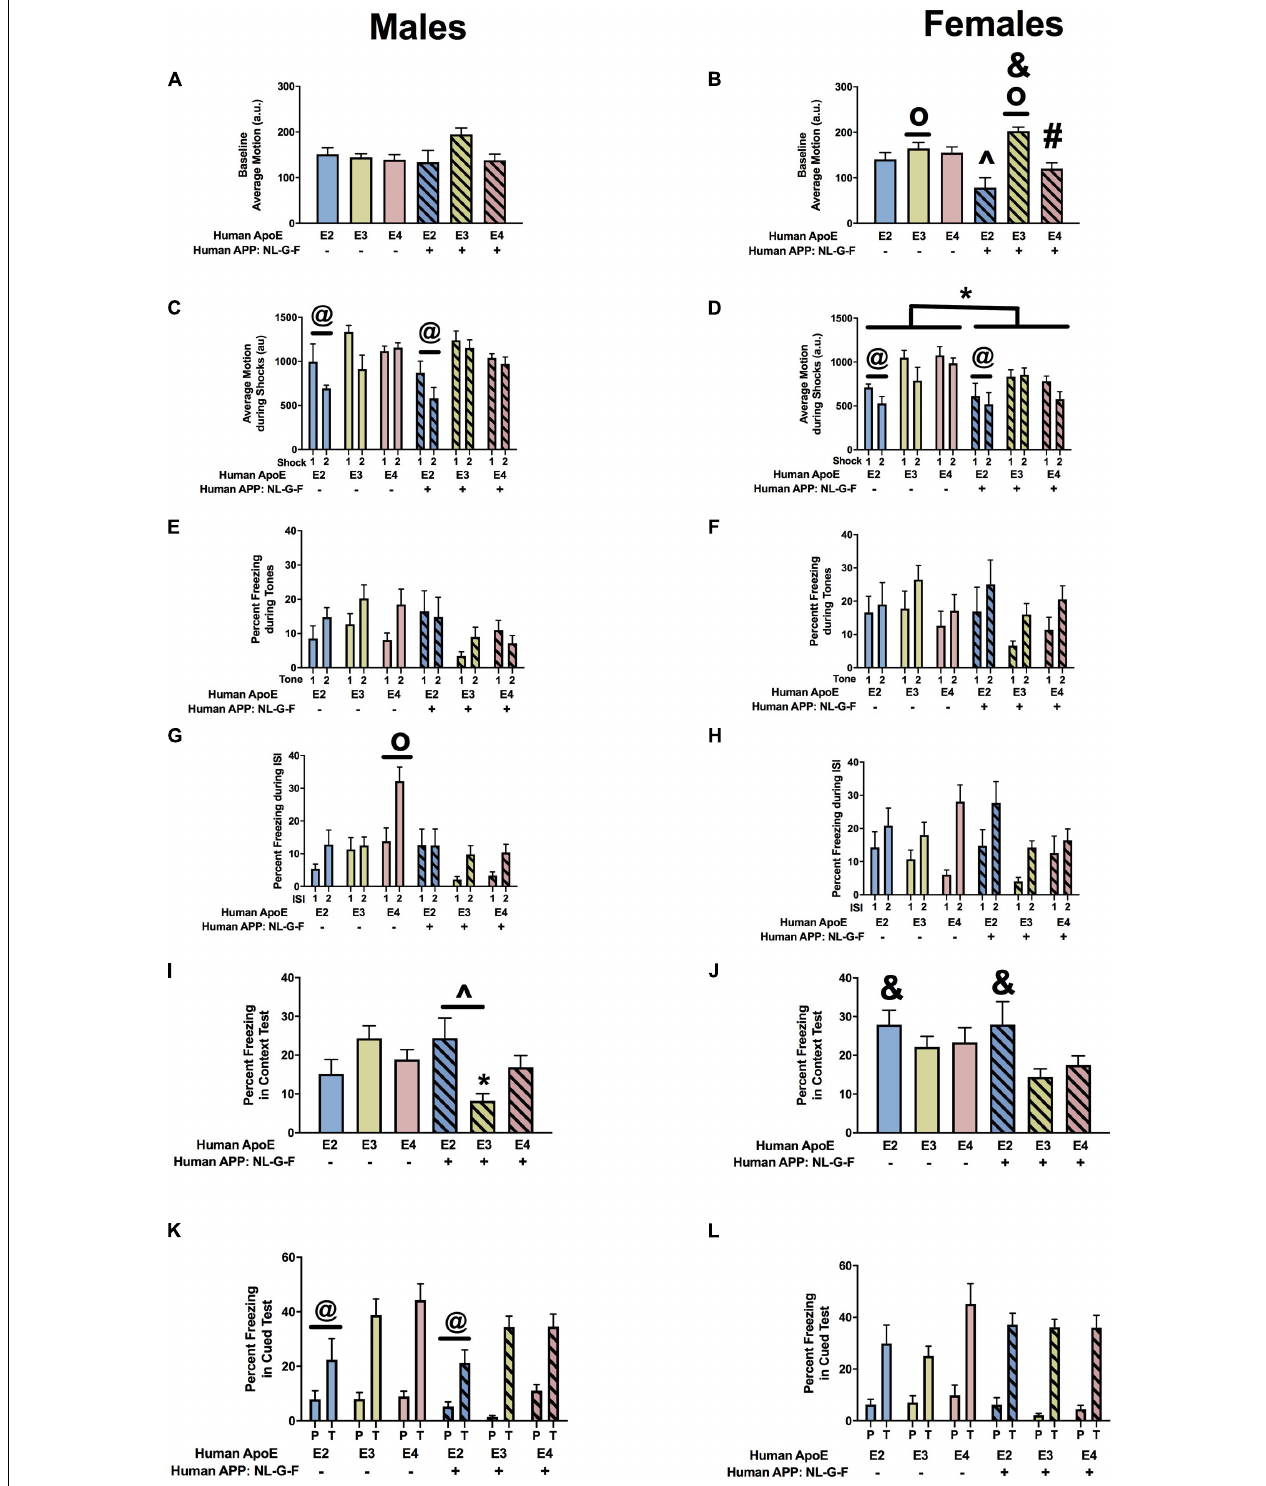
FIGURE 5 | Performance of males (A,C,E,G,I,K) and females (B,D,F,H,J,L) in the fear conditioning test at the 6-month time point. (A) Baseline motion of males prior to the first tone-shock pairing. (B) There was an effect of APOE, an APP × APOE interaction, and a trend toward an effect of APP for baseline motion of females. Baseline motion was higher in E3 than E2 and E4 females. o p < 0.05. In addition, baseline motion was higher in NL-G-F/E3 than NL-G-F/E2 and NL-G-F/E4